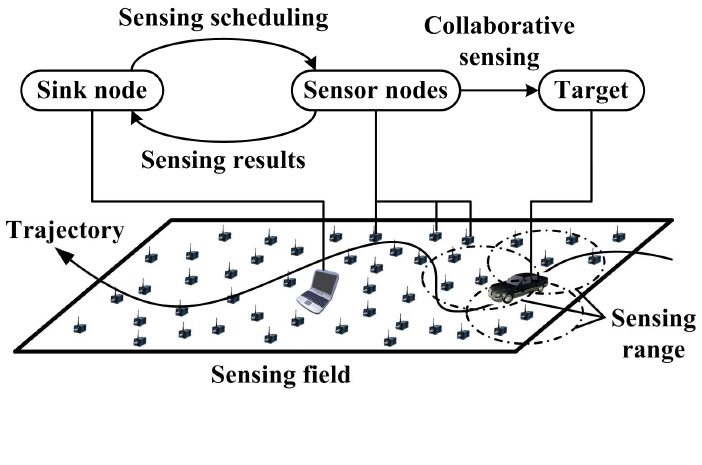
Figure 1. Energy-efficient organization framework for target tracking in